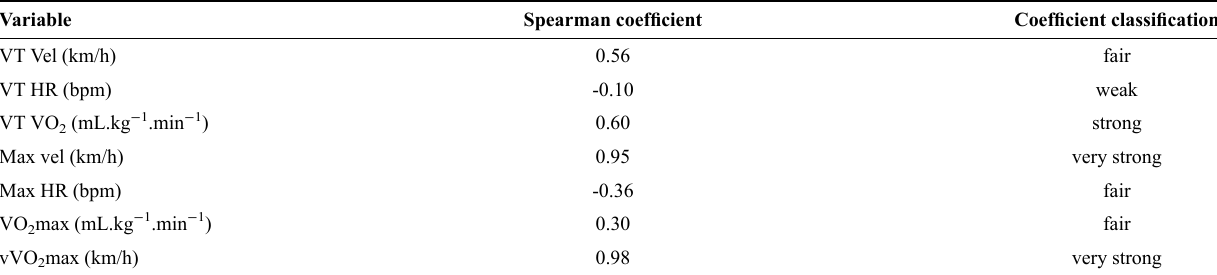
Table 2 - Correlations between cross country running points and CPET variables in military pentathlon athletes from the Brazilian Army (n=5).